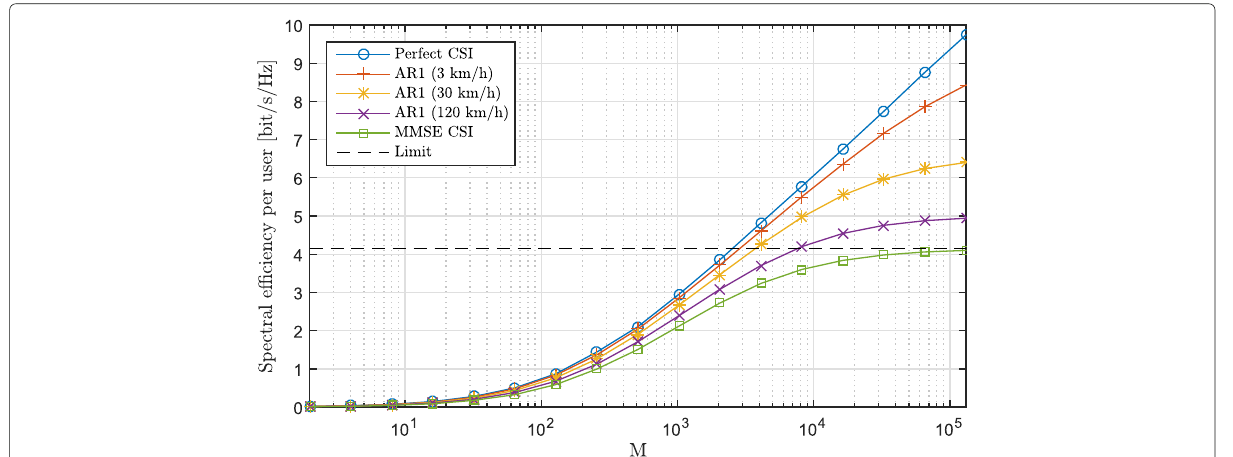
Fig. 16 The achievable uplink rate as a function of the number of antennas, M , at the